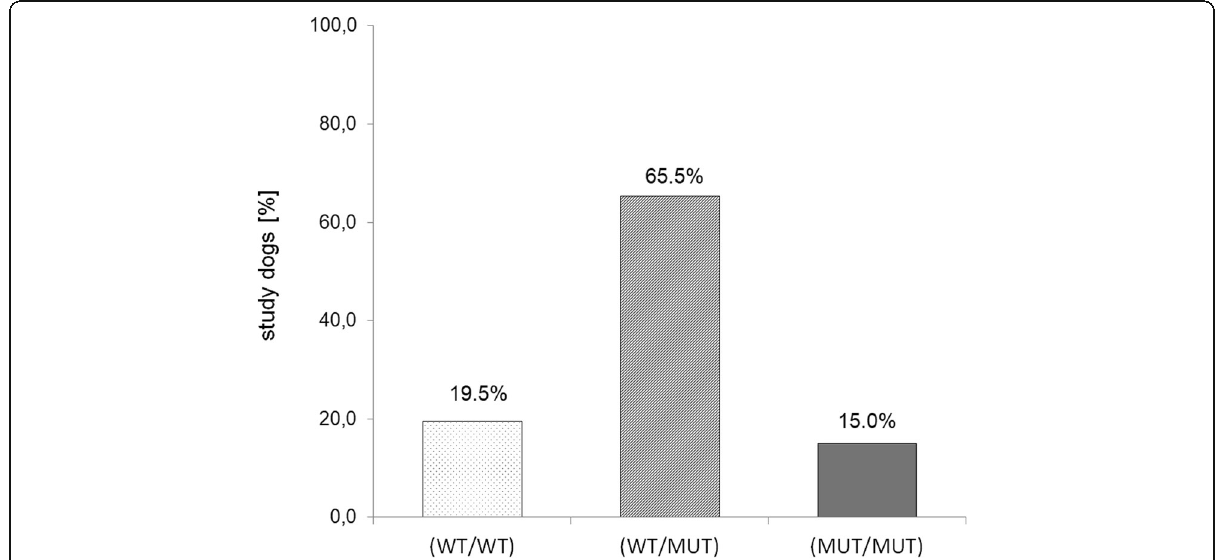
Fig. 3 Distribution of von Willebrand type I genotypes in the Kromfohrländer study population. Based on genotyping results study dogs were categorized into the following three groups: wild-type (WT/WT), heterozygous (WT/MUT) and homozygous